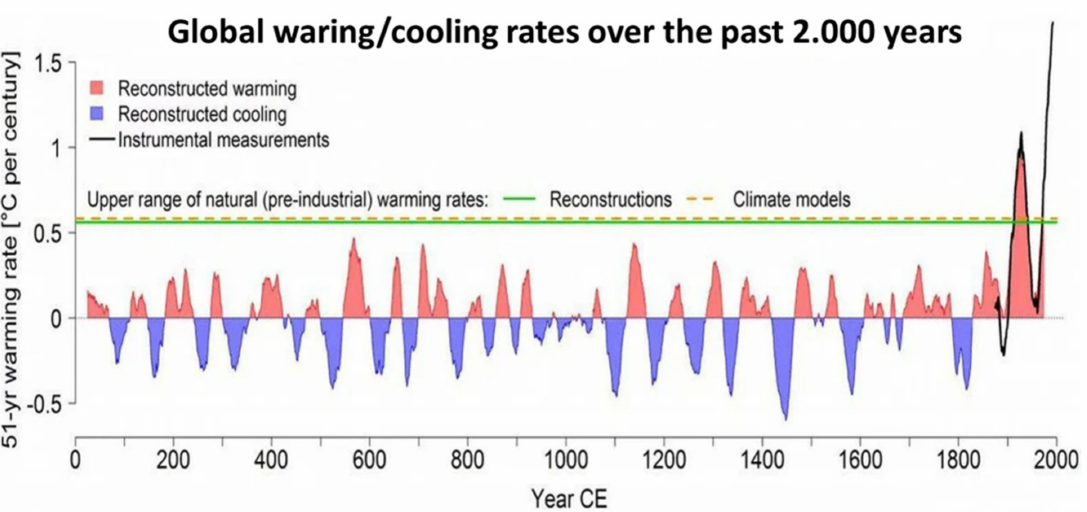
Figure 24. Natural time-scale dependence for the warming and cooling periods over the last 2000